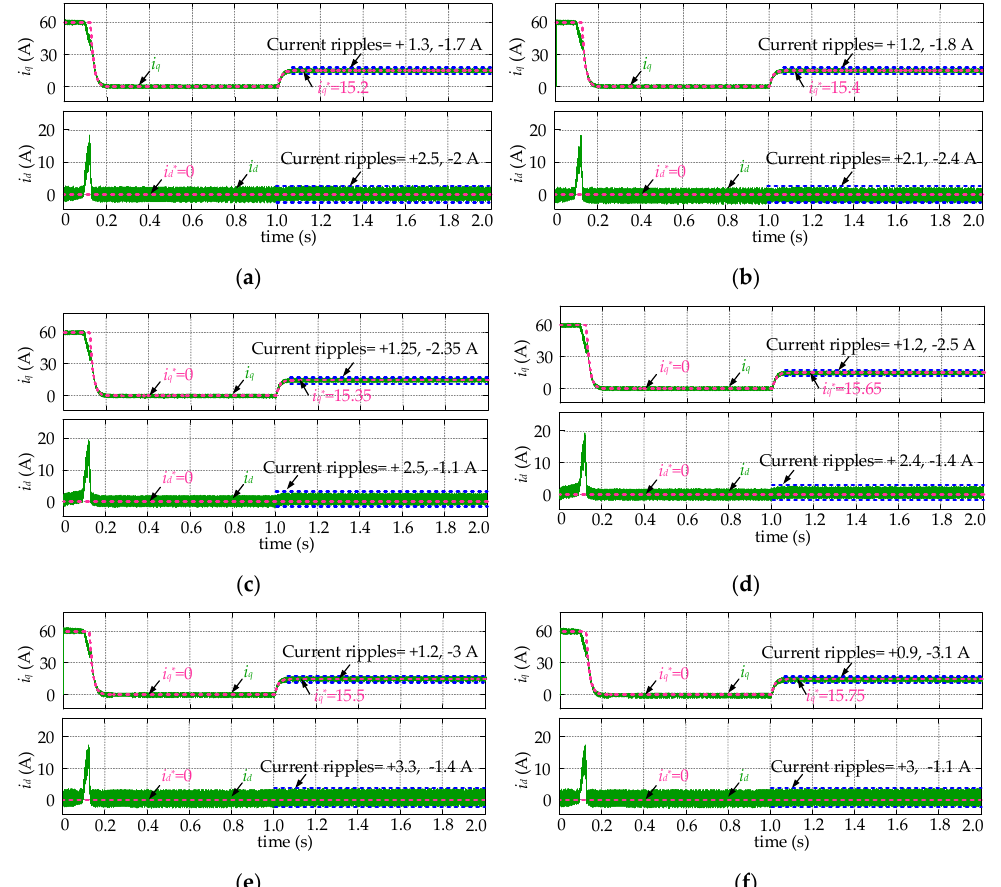
Figure 3. Current control performance under different resistance and inductance set values: ( a ) L 0 = L , ∆ L = 0, R s0 = 0.5 R s , ∆ R s = 0.5 R s ; ( b ) L 0 = L , ∆ L = 0, R s0 =5 R s , ∆ R s = − 4 R s ; ( c ) L 0 = 0.5 L , ∆ L = 0.5 L , R s0 = 0.5 R s , ∆ R s = 0.5 R s ; ( d ) L 0 = 0.5 L , ∆ L = 0.5 L , R s0 = 5 R s , ∆ R s = − 4 R s ; ( e ) L 0 = 2 L , ∆ L = − L , R s0 = 0.5 R s , ∆ R s = 0.5 R s ; ( f ) L 0 = 2 L , ∆ L = − L , R s0 = 5 R s , ∆ R s = − 4 R s .